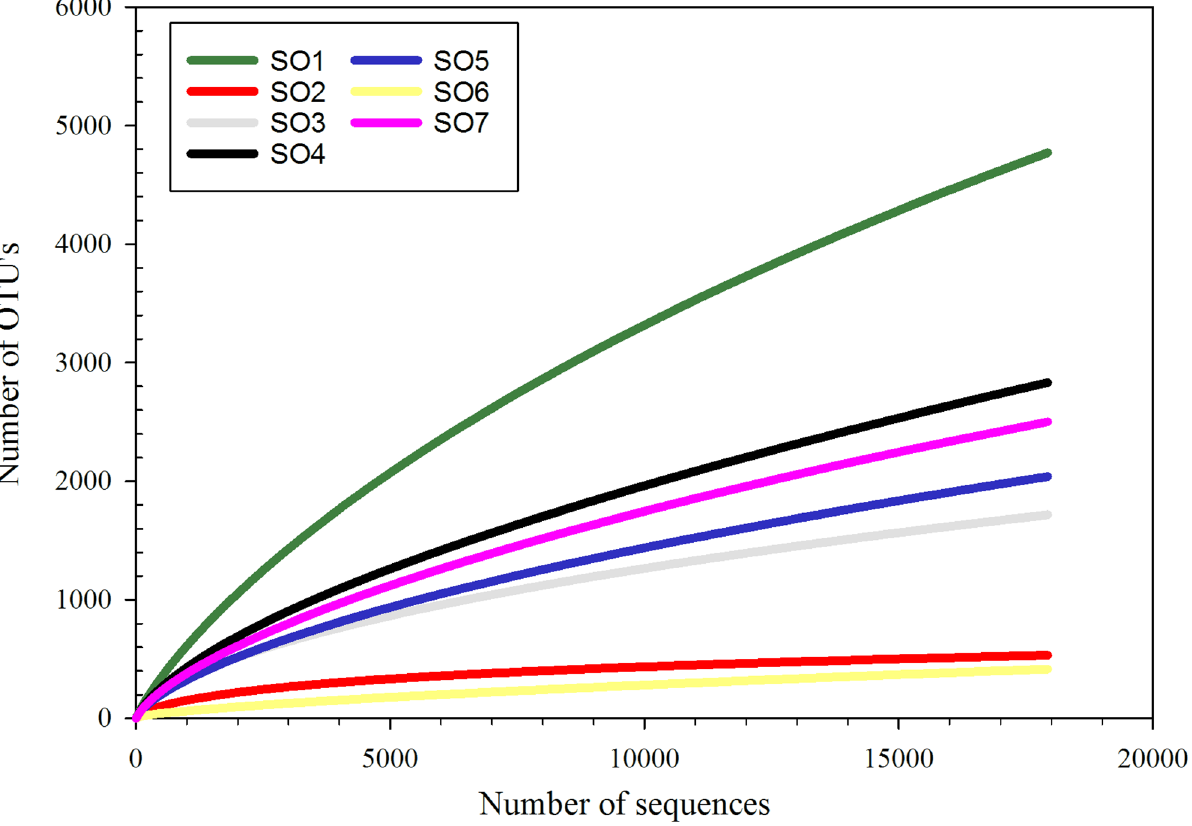
Fig 3. Rarefaction analysis of the microbial communities at the different sampling points. Curves were calculatedby MOTHUR with a 3%